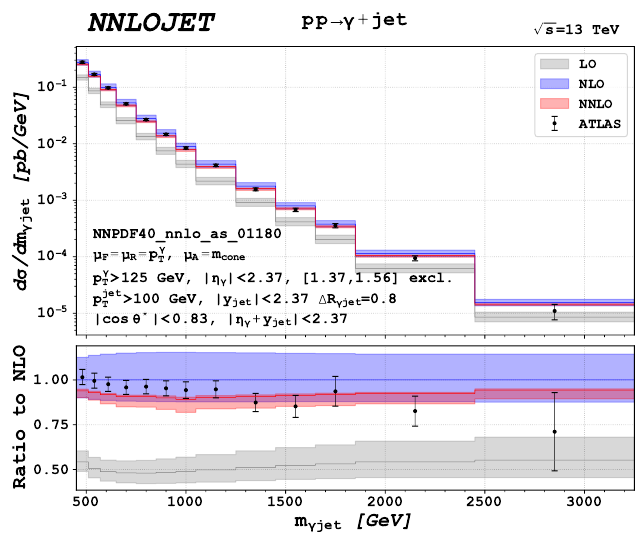
Figure 6. Predictions for the photon-jet invariant mass distributions at LO, NLO, and NNLO. The predictions are compared to data from the ATLAS measurement